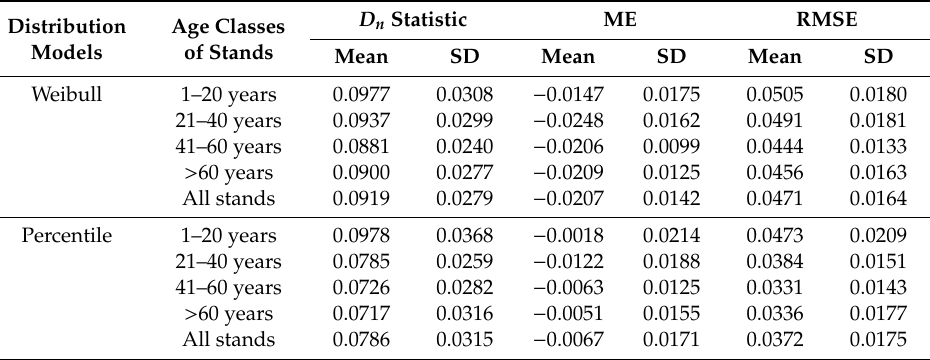
Table 3. Goodness-of-fit statistics for Weibull and percentile diameter distribution models for di ff erent stand age classes.